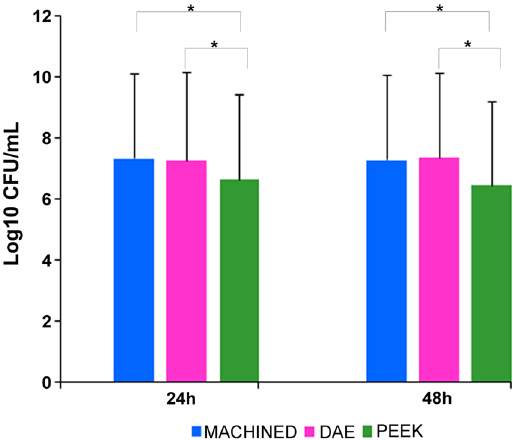
Fig. 5 Comparison of the viable adherent bacteria Log 10 CFU/mL of adherent S. oralis on titanium discs machined, DAE and PEEK ones, after 24 and 48 h of incubation (error bars = ±standard